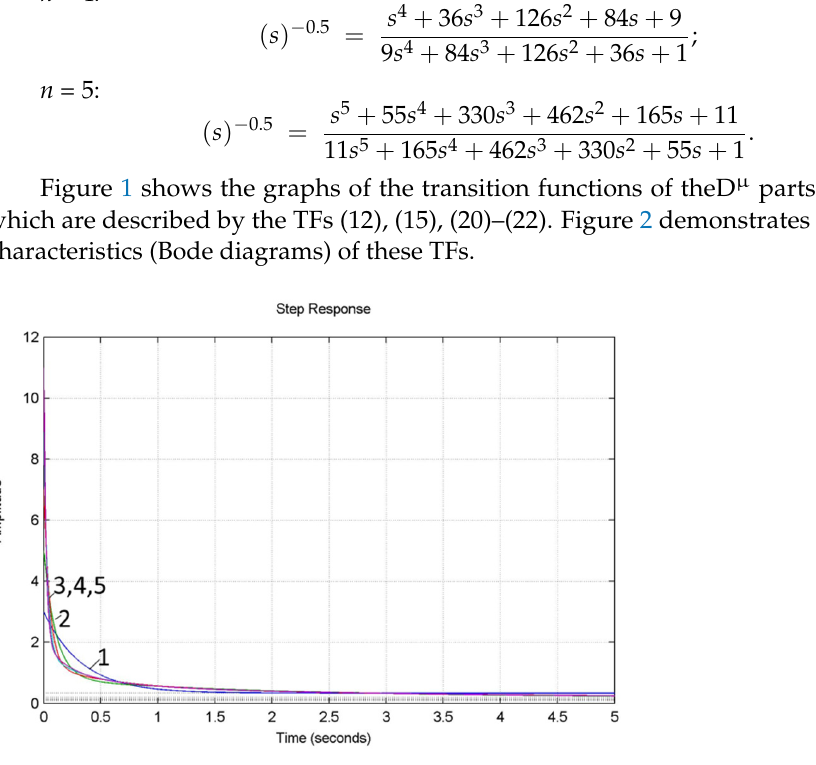
Figure 1. Transition processes of parts (12)—1, (15)—2, (20)—3, (21)—4, (22)—5.